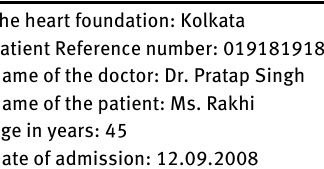
Table 3: Sample Electronic Healthcare Record.